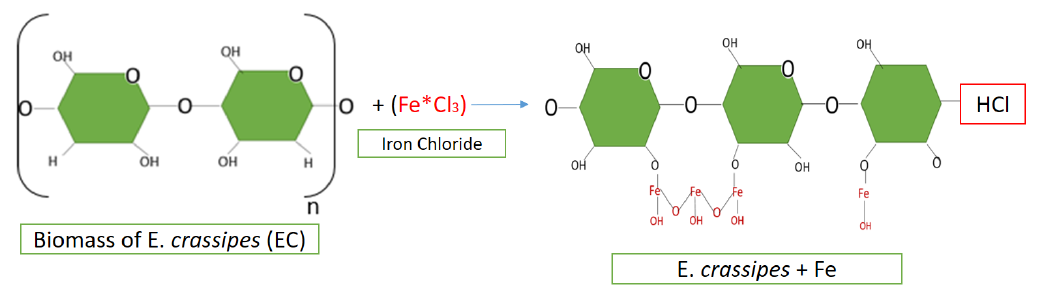
Figure 4. Representation of reaction between cellulose and iron chloride.